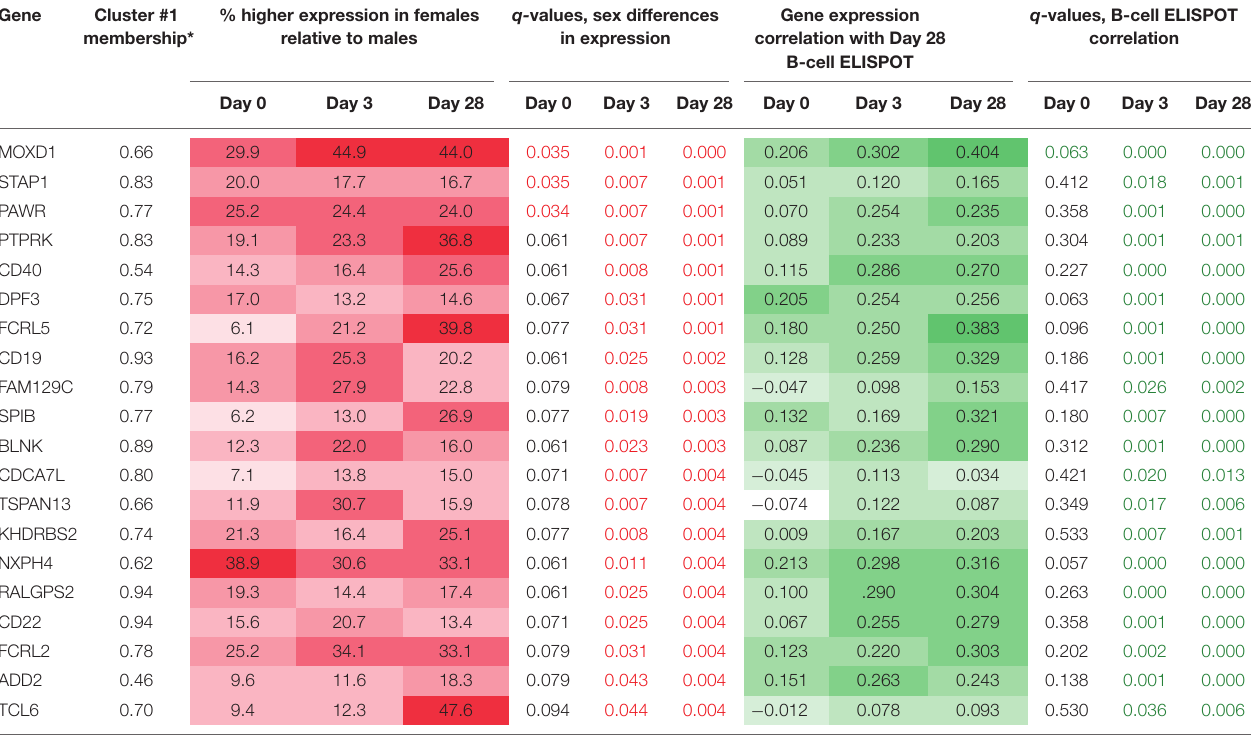
TABLE 2 | Gene cluster #1 genes with significant differences in expression levels between males and females. Gene Cluster #1 % higher expression in females membership* relative to males